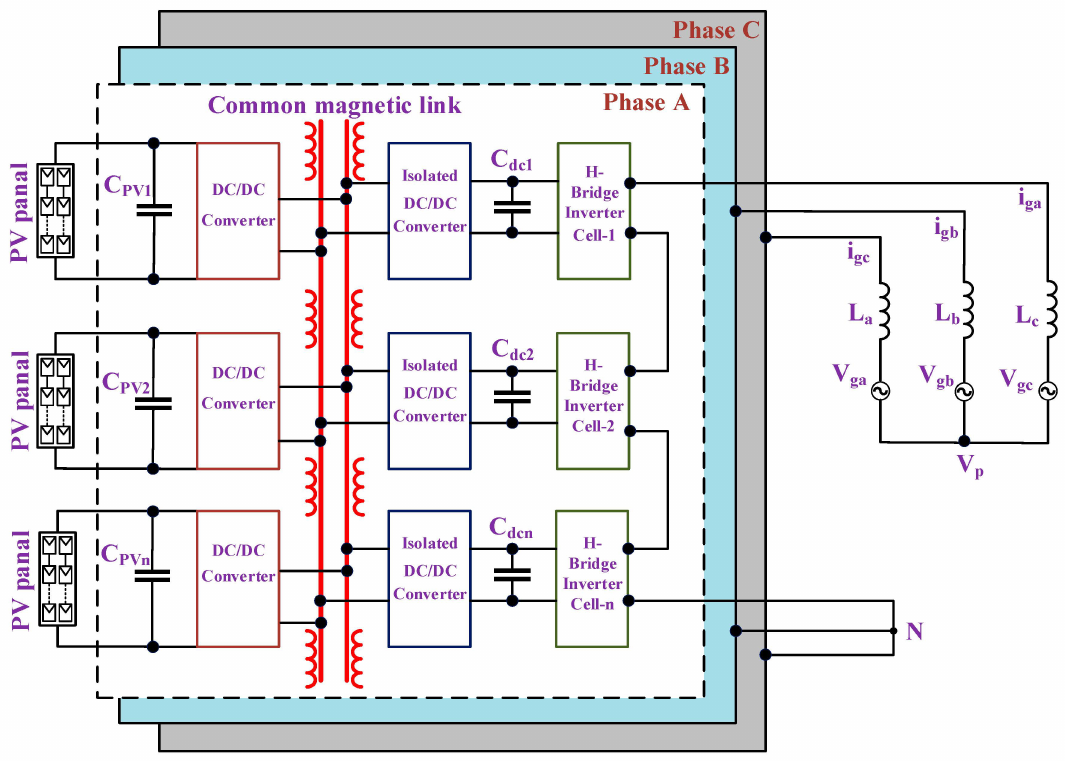
Figure 12. A CHB MMI with a common magnetic link